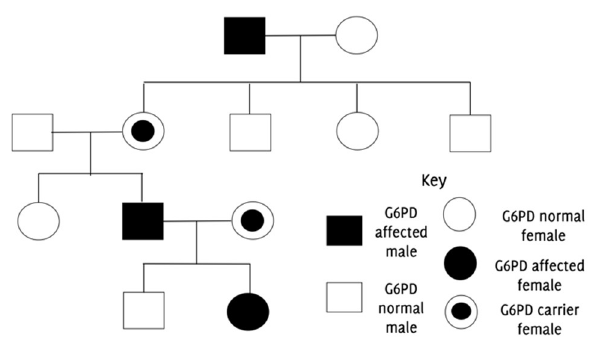
Figure 1 . Pedigree chart indicating X-linked inheritance pattern of G6PD